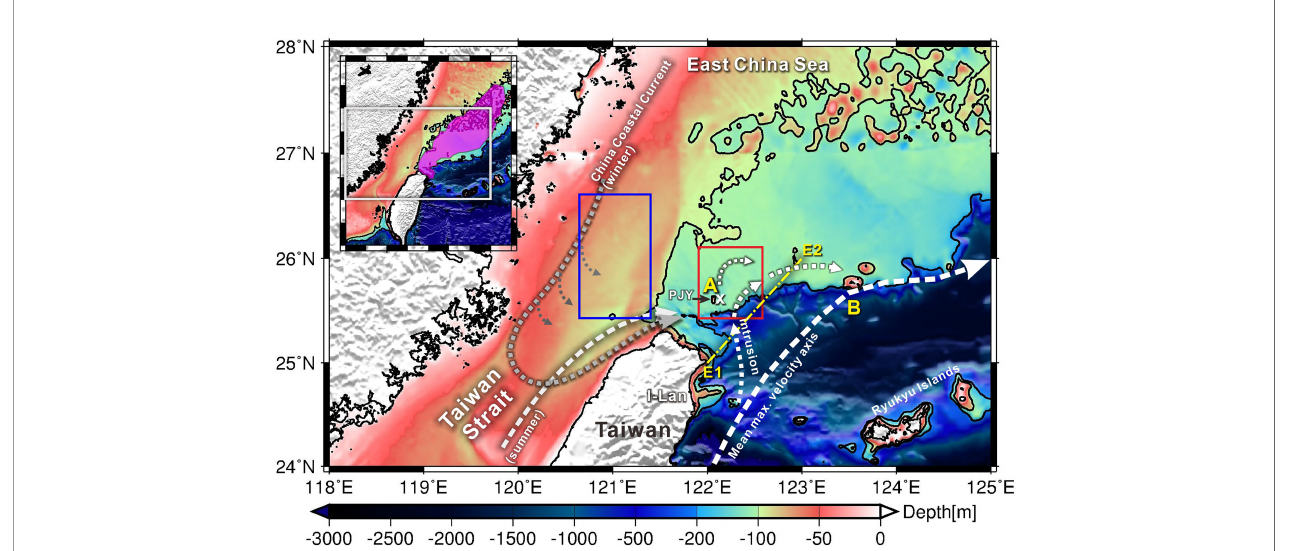
FIGURE 1 | Topography and schematic routes of major currents around northern Taiwan. “ X ” indicates the mean center position of relatively low-temperature surface water in the cold dome (Jan et al., 2011). The transparent purple shading region in the inset bounds the majority of vessel locations with swordtip squid catches. Red and blue rectangles are used to evaluate the velocity dominance of the Kuroshio intrusion and China Coastal Current, respectively, in the cold dome region. Points A and B are used to calculate the satellite SST difference between the Kuroshio ’ s mean maximum velocity axis and the cold dome. The E1 – E2 section (dotted yellow line) is used in the calculation of cross-shelf Ekman